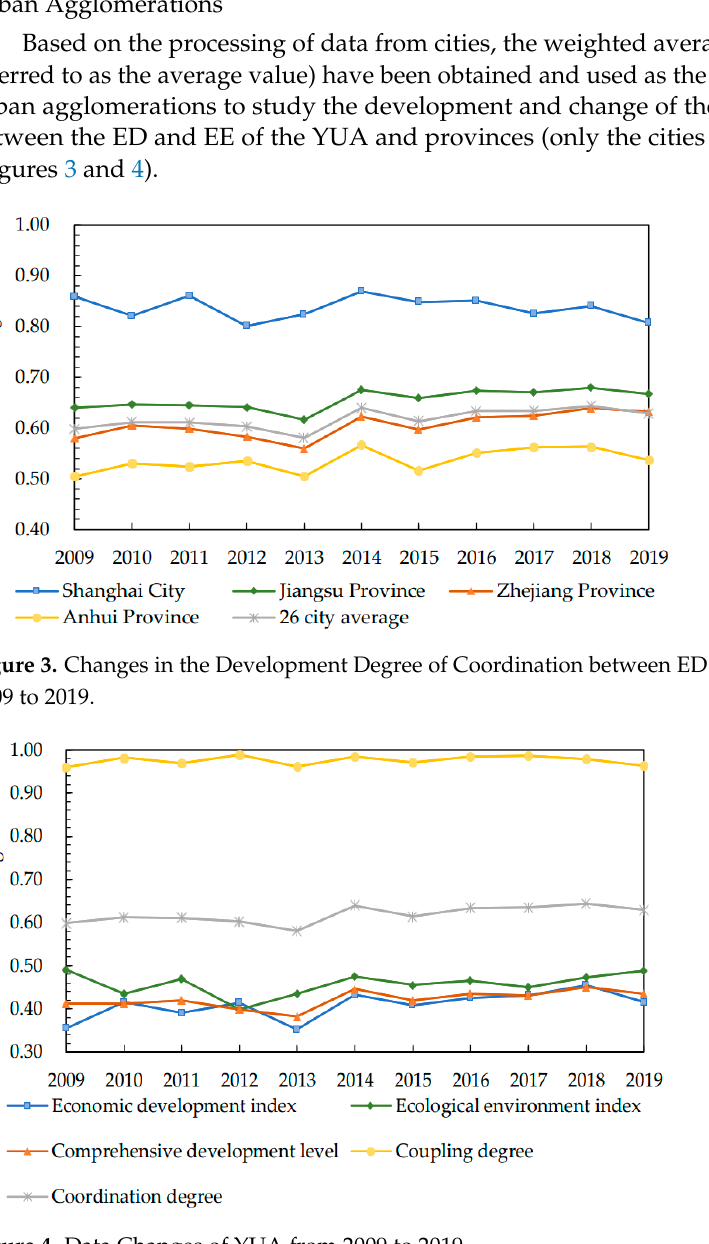
Figure 4. Data Changes of YUA from 2009 to 2019.